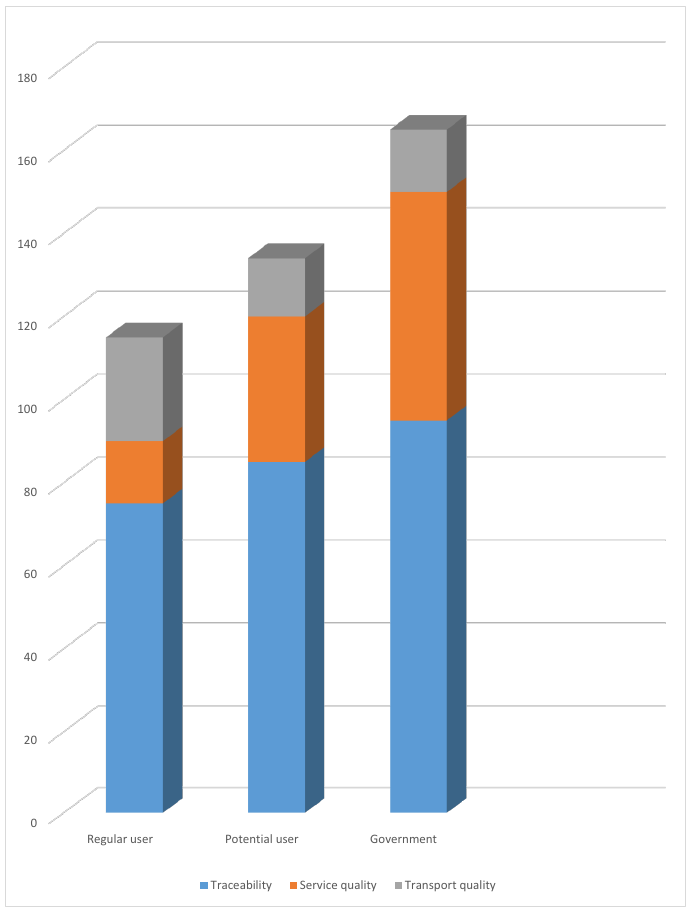
Figure 1. Comparison of the scores derived from FAHP for the first level of decision